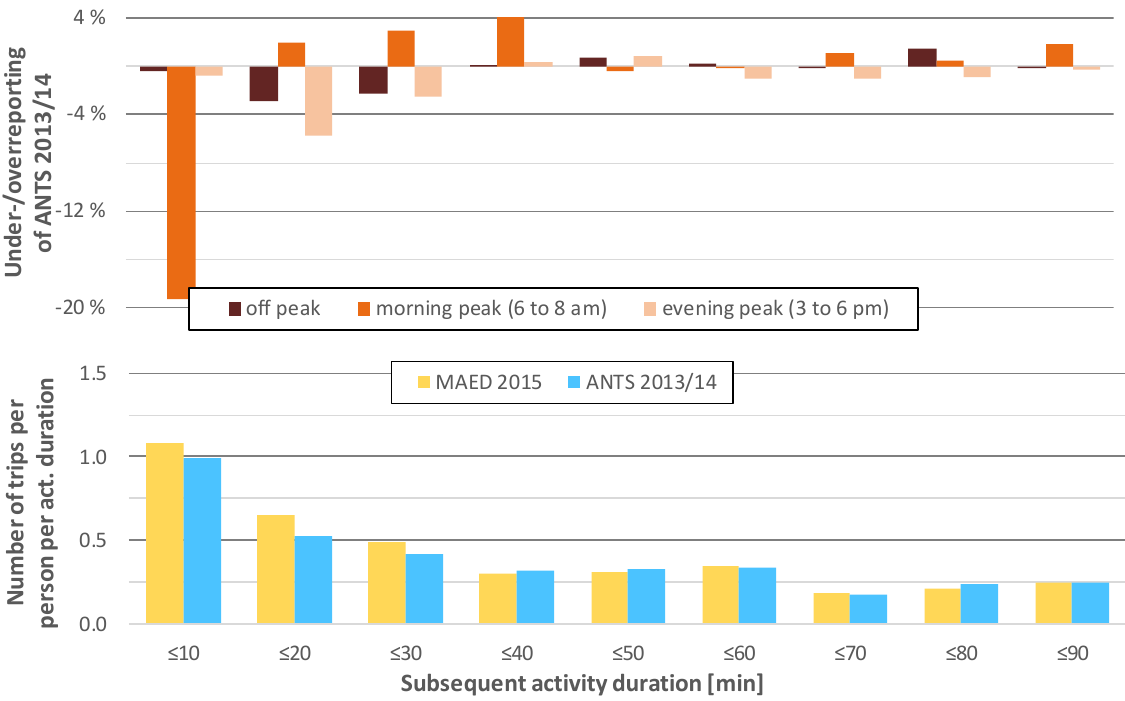
Figure 5. Distribution of trips with regard to their subsequent activity duration (up to 90 minutes; below), and respective under-/overreporting of ANTS 2013/14 (above). Only persons with at least two trips are